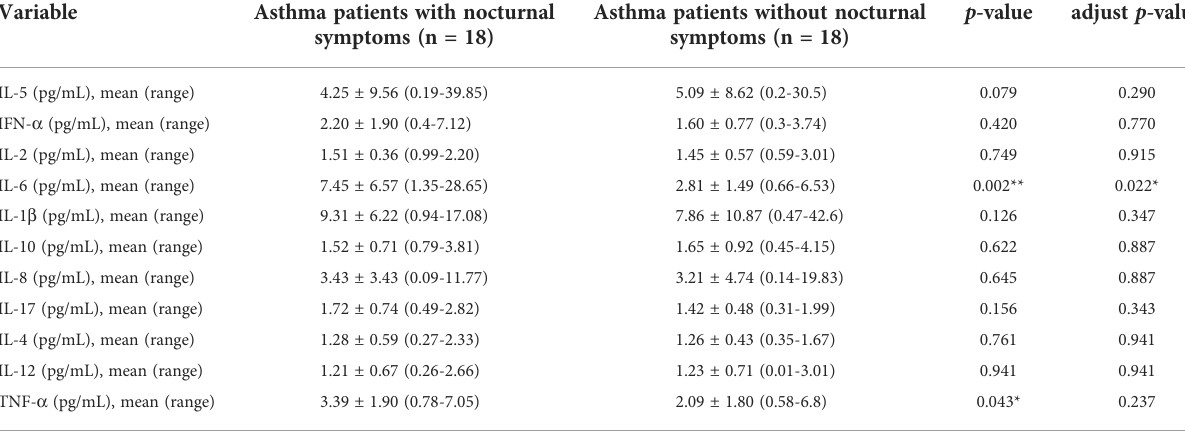
TABLE 2 In fl ammatory cytokines of asthma patients with or without nocturnal symptoms. Variable Asthma patients with nocturnal symptoms (n =